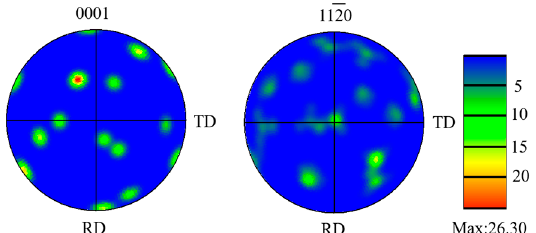
Figure 8. Pole figures of WM.